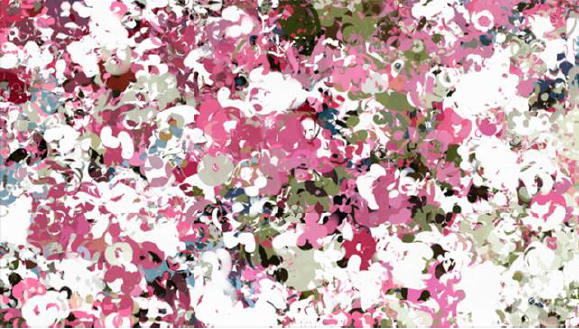
Figure 4. Casey Reas: Process 14 (Software 3) 2012. Credit: C.